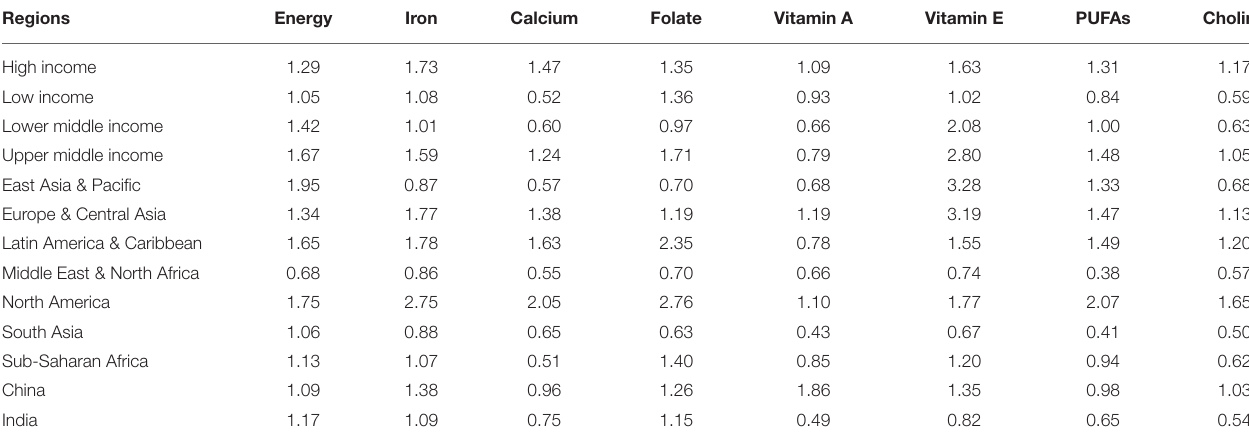
TABLE 2 | Regional nutrient production adequacy ratios for the selected nutrients.